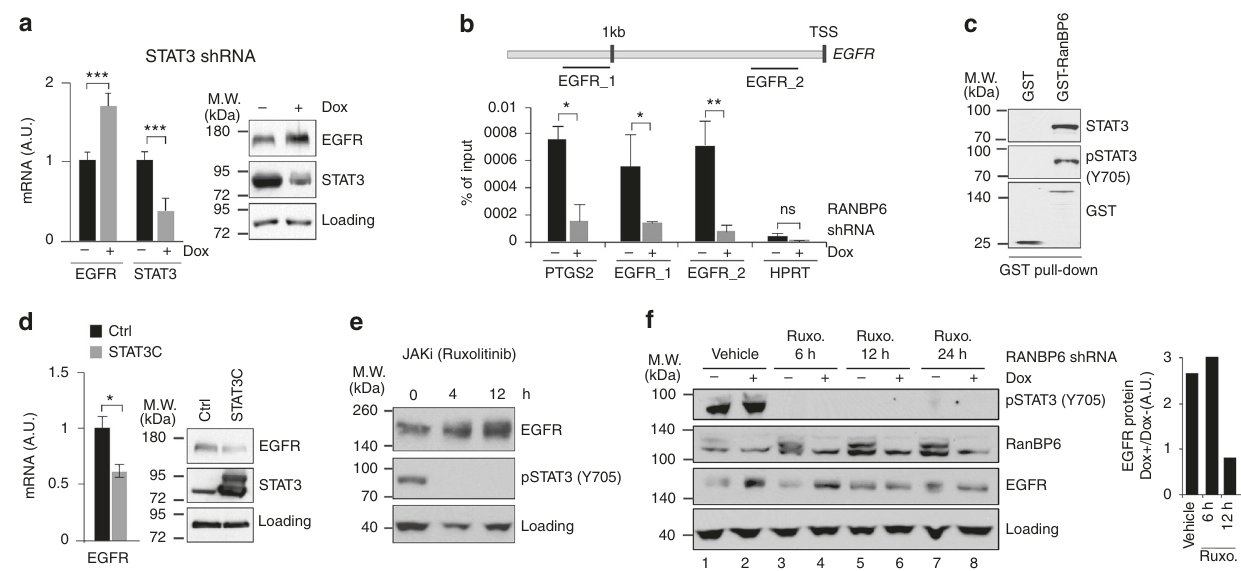
Fig. 4 STAT3 represses EGFR transcription. a STAT3 KD raises EGFR mRNA (left panel) and EGFR protein levels (right panel) in HEK-293T. b STAT3 binding to the EGFR promoter is impaired by RanBP6 KD. Bottom panel, ChIP experiments on the promoter of indicated genes with STAT3 antibody in LN18 cells with Dox-inducible shRanBP6. Plotted values are relative enrichments to % input, measured for two regions (EGFR_1 and EGFR_2) in 1.5 kb upstream of EGFR transcriptional start site (TSS) (see top panel). Binding to the PTGS2 and HPRT promoter was used as positive and negative control, respectively. c STAT3 and p-STAT3 (Y-705) bind GST-RanBP6 fusion protein in HEK-293T whole-cell lysates. d Expression of a constitutive active STAT3 mutant decreases EGFR mRNA (left panel) and EGFR protein levels (right panel) in HEK-293T. e Inhibition of STAT3 activation by JAK kinase inhibitor ruxolitinib raised EGFR protein level in HEK293T. f JAK-STAT blockage with ruxolitinib mitigates the effect of RanBP6 KD on EGFR protein levels in HEK-293T. Right panel, densitometric analysis of EGFR ratio between Dox+ and Dox − samples for each treatment. Data in bar graphs are represented as mean ± SD ( n ≥